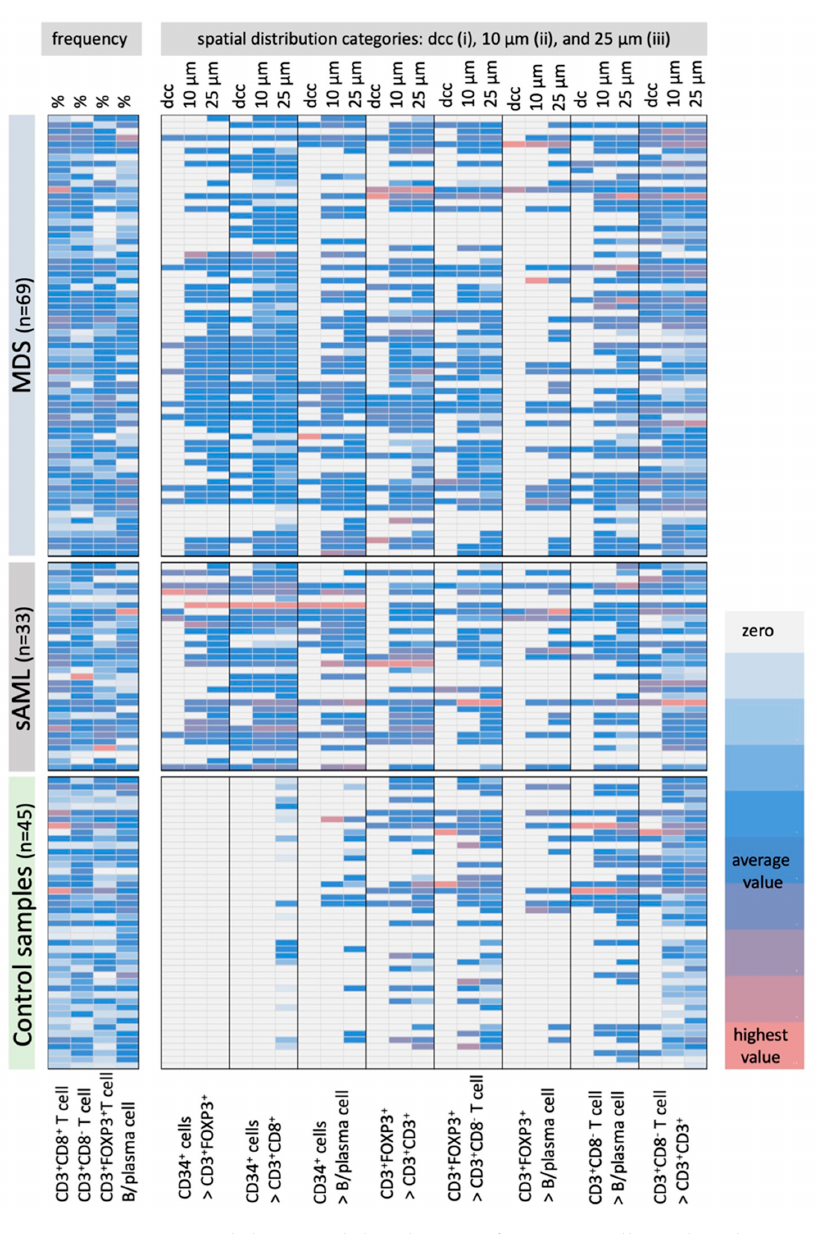
Figure 2. Frequency and the spatial distribution of immune cells analyzed in BMB from controls and MDS/sAML patients in correlation to CD34 + blasts. MSI data of 45 control samples, 65 MDS and 33 AML BMB were evaluated regarding the frequencies of CD3+CD8+ T cells, CD3+CD8 − T cells, CD3+FOXP3+ T cells and MUM1p+CD3 − B/plasma cells as well as their spatial distribution to each other and to the CD34+ HSPC/blasts (CD34+ blasts in relation (>) to CD3+FOXP3+ T cells, CD3+CD8+ T cells, MUM1p+CD3 − B/plasma cells; CD3+FOXP3+ T cells in relation (>) to CD3+CD8+ T cells, to CD3+CD8 − T cells MUM1p+CD3 − B/plasma cells, and CD3+CD8 − T cells in relation (>) to MUM1p+CD3 − B/plasma cells and CD3+CD8 − T cells) and results are represented in a heat map. All spatial relations are depicted according to the categorization in direct cellular contact (dcc), the 10 µ m and the 25 µ m radius, respectively. The number of cells in each spatial category or the frequency of the immune cells are color-coded, in which white/light grey codes for lowest value, blue codes for average value and light red codes for highest value of immune cell subsets. Most remarkable is the presence of only few B/plasma cells and no CD3+CD8+ and CD3+FOXP3+ T cell subpopulations in the proximity to CD34+ HSPC in the control samples, while the frequency of these immune cell subpopulations is comparable within the BM of MDS and sAML